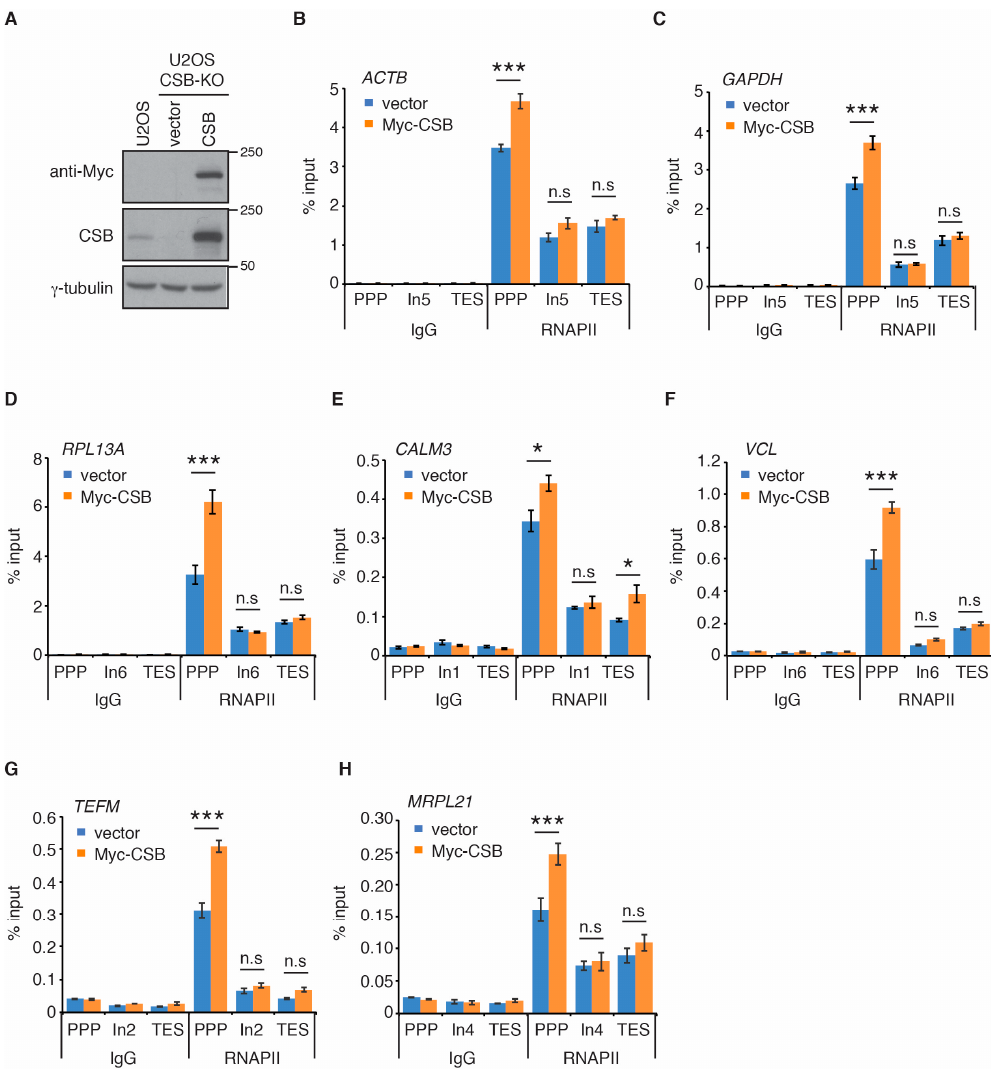
Figure 2. Re-introduction of wild type CSB rescues RNAPII occupancy at PPP sites. ( A ) Western analysis of U2OS cells as well as U2OS CSB-KO cells complemented with the vector alone or Myc-CSB. Immunoblotting was performed with anti-Myc, anti-CSB, and anti- γ -tubulin antibodies. ( B – H ) RNAPII ChIP analyses of ACTB , GAPDH , RPL13A , CALM3 , VCL , TEFM and MRPL21 genes in U2OS CSB-KO cells expressing the vector alone or Myc-CSB. Standard errors from three independent experiments are shown. p values were derived using the 2-way ANOVA test. * p < 0.05; *** p < 0.001, n.s.: not